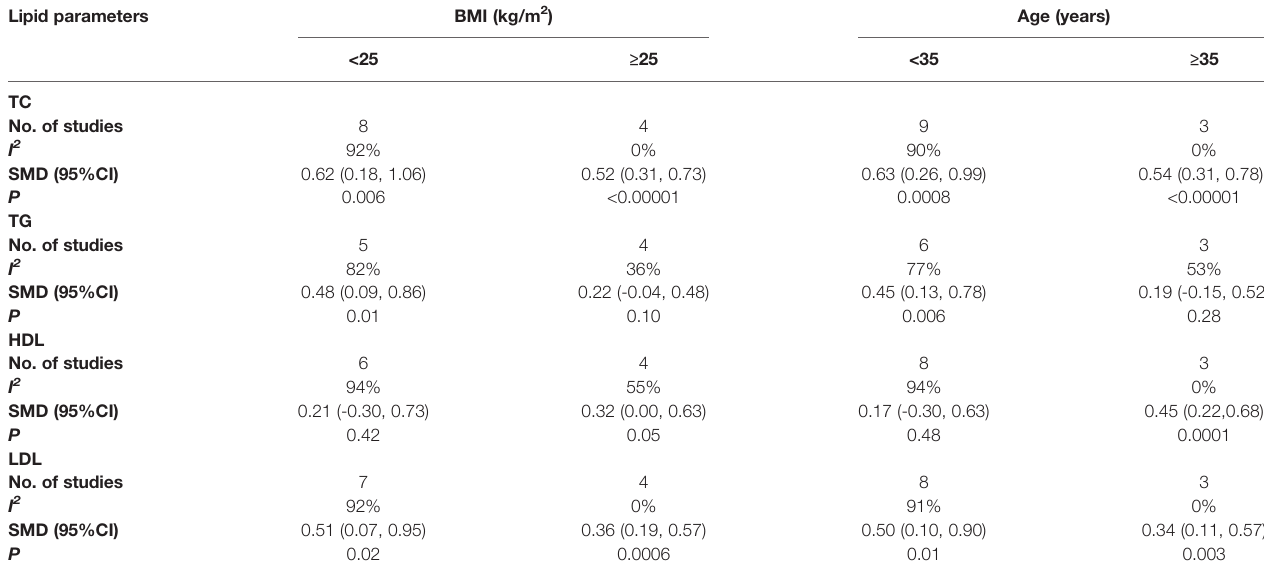
TABLE 4 | Subgroup analysis to investigate the relationship between mean BMI value of cases, mean age of cases and TC, TG, HDL, LDL. Lipid